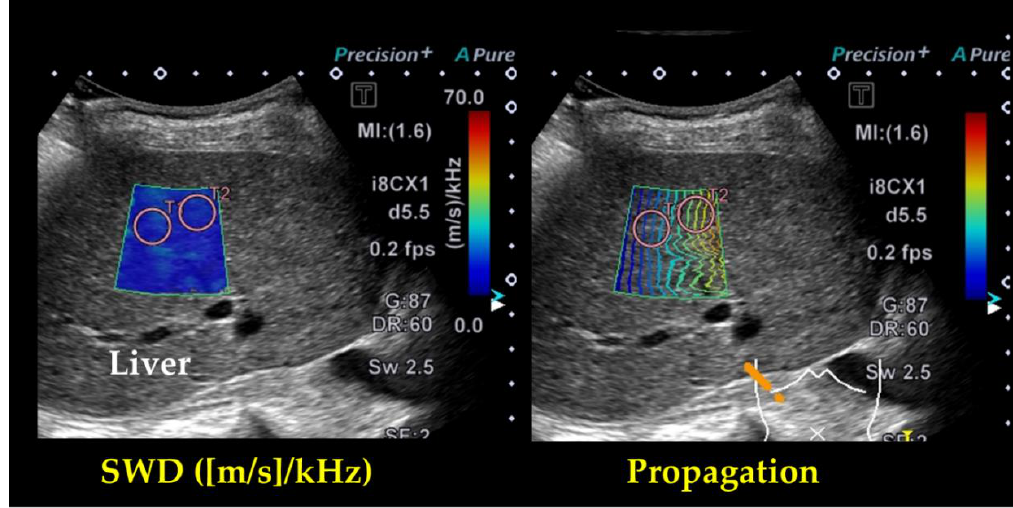
Figure 1. Representative images of shear wave dispersion (SWD) in a patient with heart failure (HF). A 3 × 3 cm sized sample box was placed in the liver parenchyma and then shear wave propagation was activated by using acoustic radiation force. The shear wave propagation was seen within the sample box as smooth parallel lines indicating a stable measurement condition. Two regions of interest with a diameter of 1.0 cm are placed within the sample box. The SWD on its map is as follows. T1: 11.55 (m/s)/kHz, T2: 11.27 (m/s)/kHz.